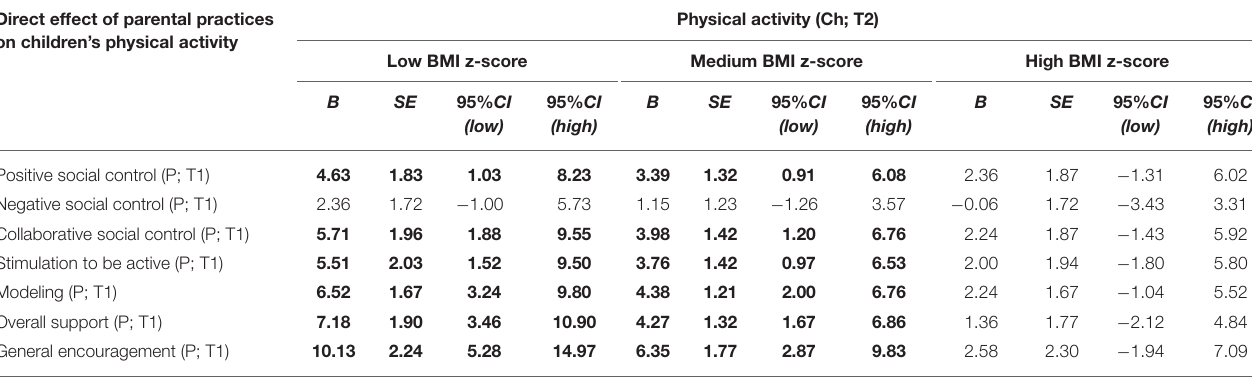
TABLE 3 | Effect of parental practices associated with physical activity as independent variable on physical activity of children as dependent variable and the BMI z-score as moderator. Direct effect of parental practices on children’s physical